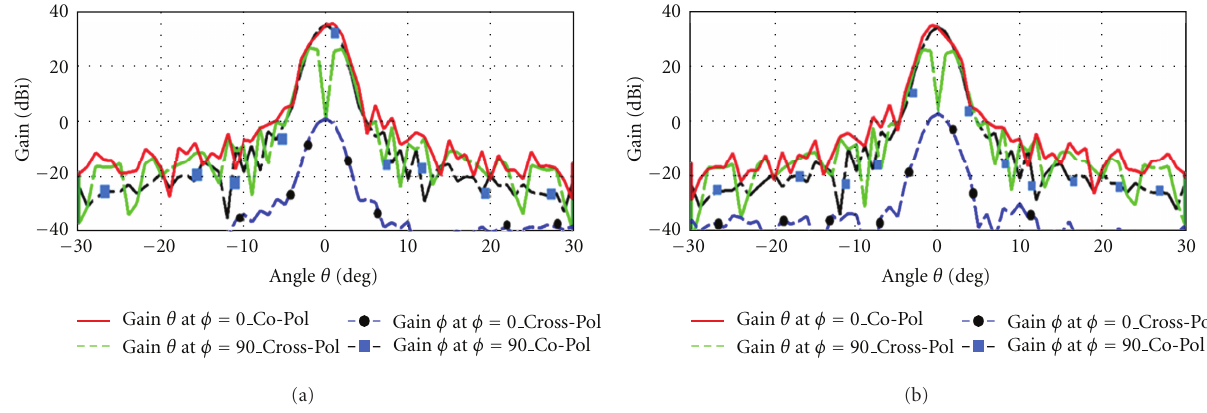
Figure 8: Reflector antenna radiation patterns at 7.73 GHz with the feedhorn mode combination of TE 11 (50%) + TM 01 (50%) for the fixed phase values of (a) +90 ◦ and (b) − 90 ◦ .